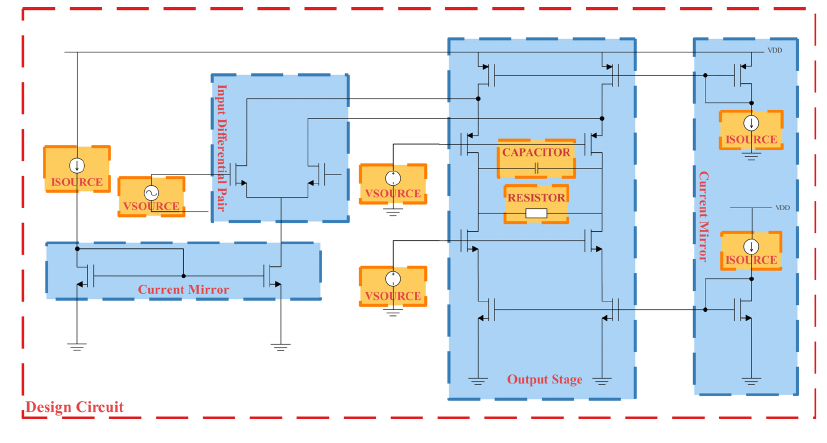
Electronics 2023 , 12 , x FOR PEER REVIEW Figure 3. Folded hierarchical netlist. Figure 3. Folded hierarchical netlist.